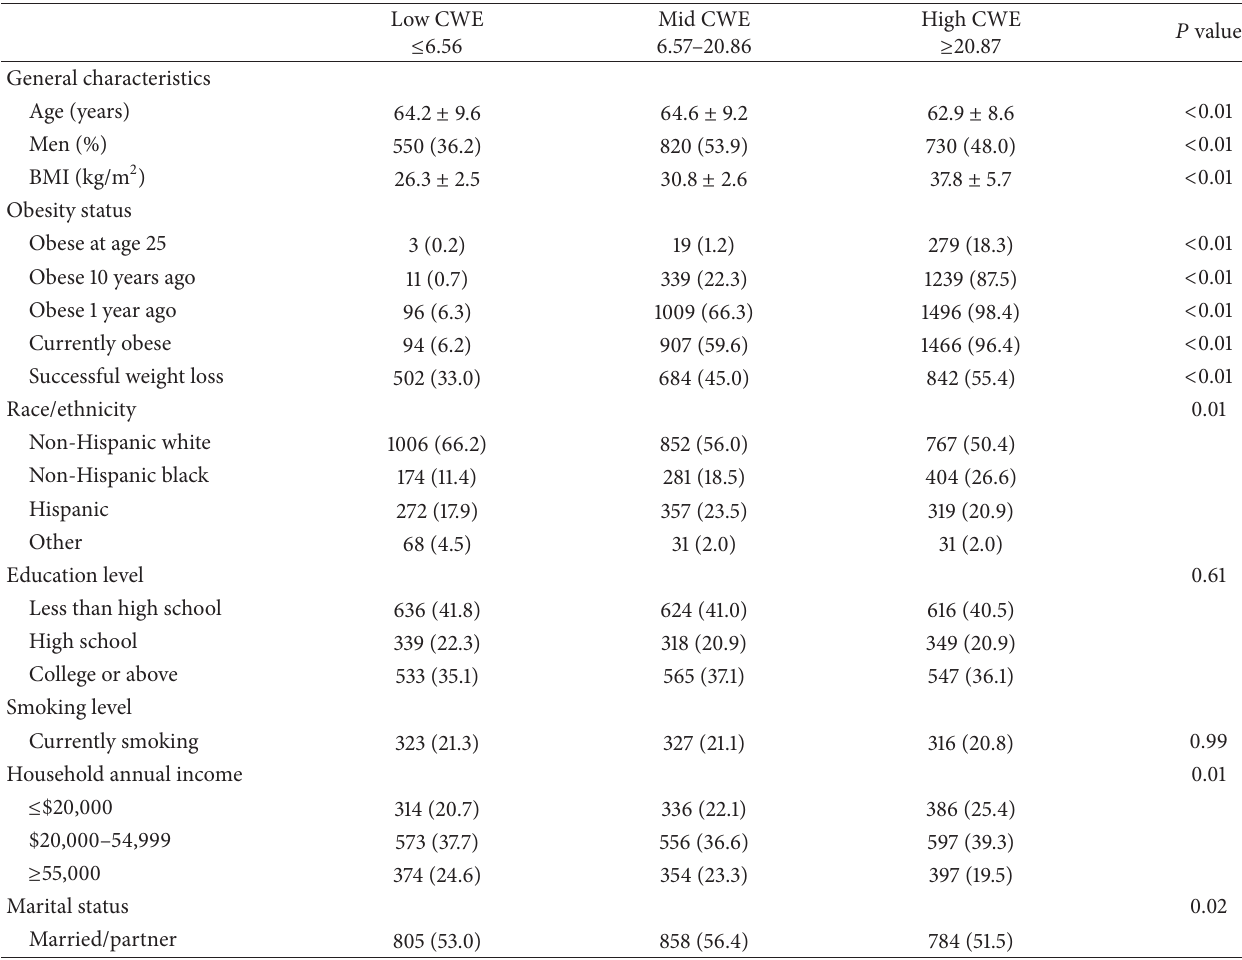
Table 1: Characteristics of the 4562 study